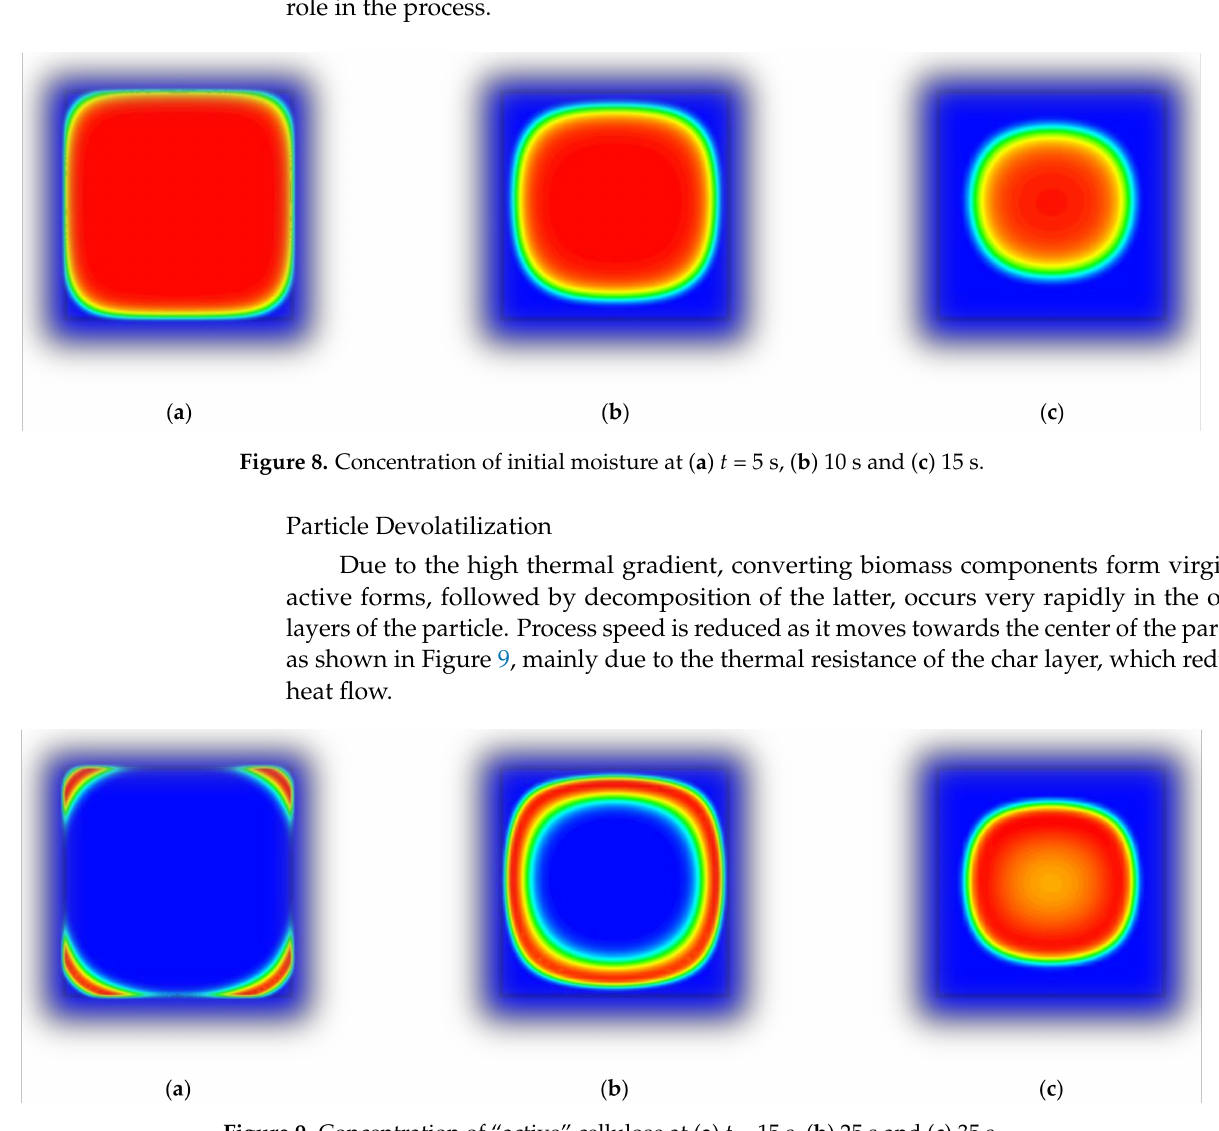
Figure 9. Concentration of “active” cellulose at ( a ) t = 15 s, ( b ) 25 s and ( c ) 35 s. Char formation (Figure 10) by biomass components decomposition occurs sequentially, with cellulose, hemicellulose and lignin decomposition temperatures and speeds being different. For instance, lignin is the last to decompose at significantly higher temperatures than hemicellulose, which means that the formation of carbon residue can occur simultane- ously on a significant fraction of the total particle thickness. However, at the same time, char decomposition occurs due to the combined action of the gasification reactions and, more importantly, the oxidation